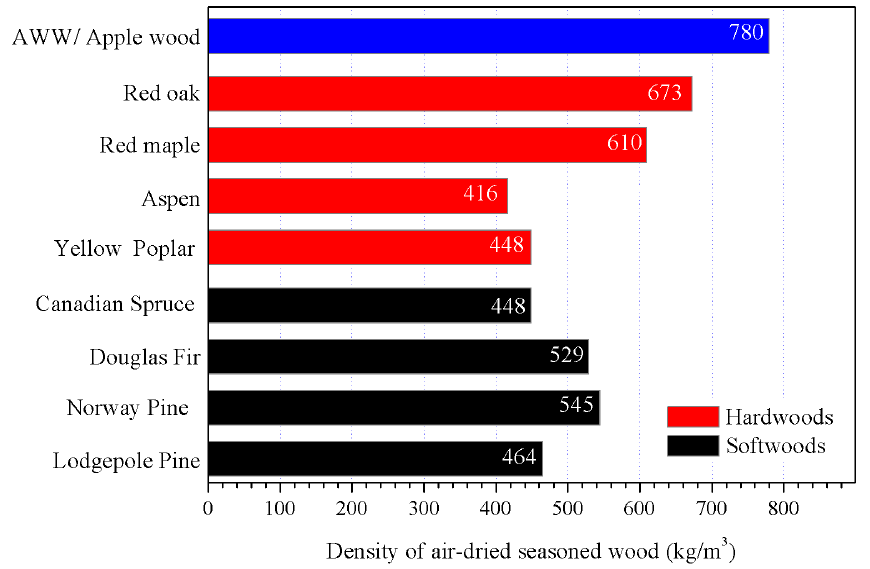
Figure 2. Comparison of densities of air-dried seasoned woods. Data are available online: https://www.engineeringtoolbox.com/weigt-wood-d_821.html (accessed on 30 January 2023).